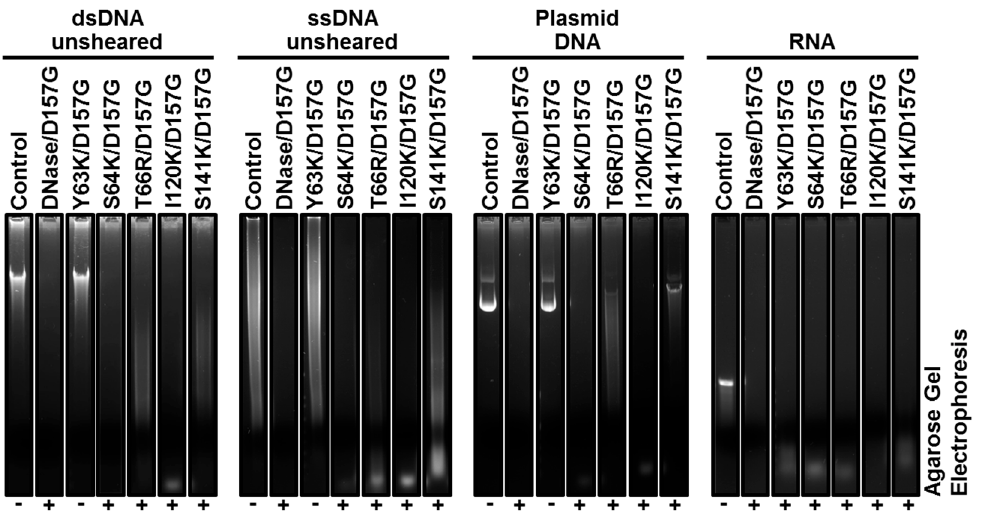
Figure 6. Substrate specificity of mutants with amino acid substitutions in the inner ring. Mutant Y63K/D157G was not able to degrade any type of nucleic acid. Mutants S64K/D157G, T66R/D157G, and I120K/D157G partially degraded all types of nucleic acids within 1 h at 25 °C, while mutant S141K/D157G exhibited low levels of degradation activity. “Control” indicates negative controls containing substrate but no enzyme in the reaction mixture.